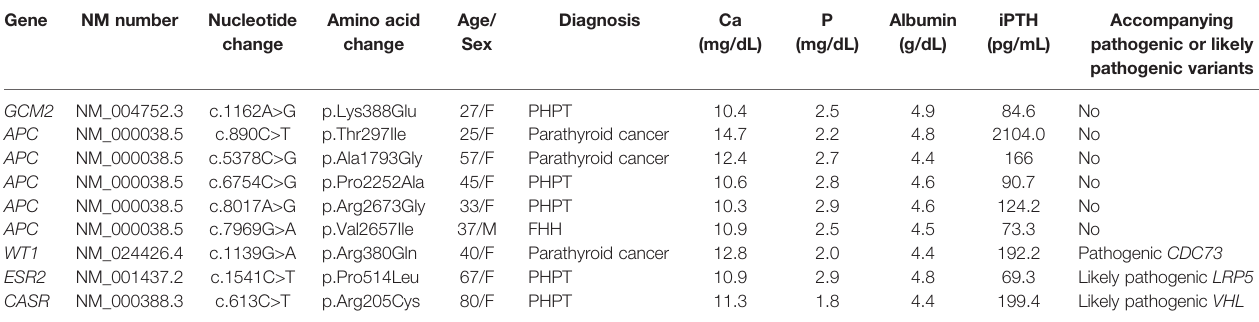
TABLE 3 | Patients with VUSs in GCM2 , APC , WT1 , ESR2 , and CASR genes.